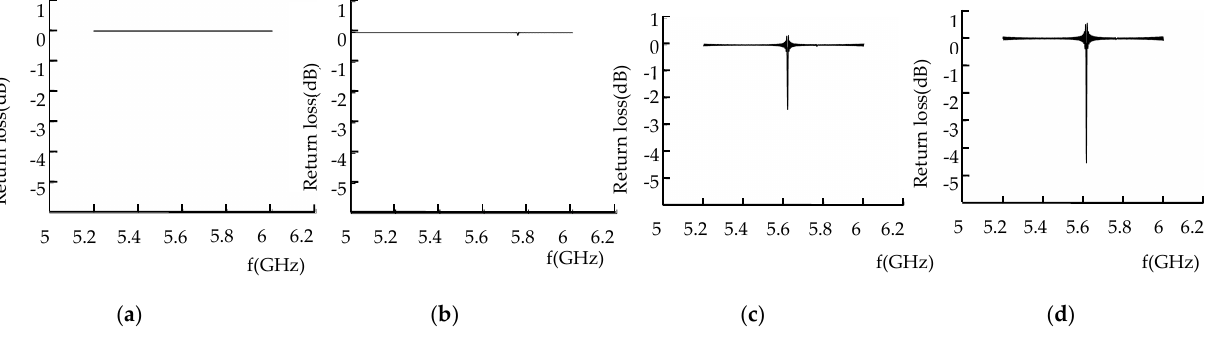
Figure 11. Return loss of rectangular defects with different sizes. ( a ) No defect. ( b ) Crack defect. ( c ) Triangular prism defect. ( d ) Trapezoid defect.